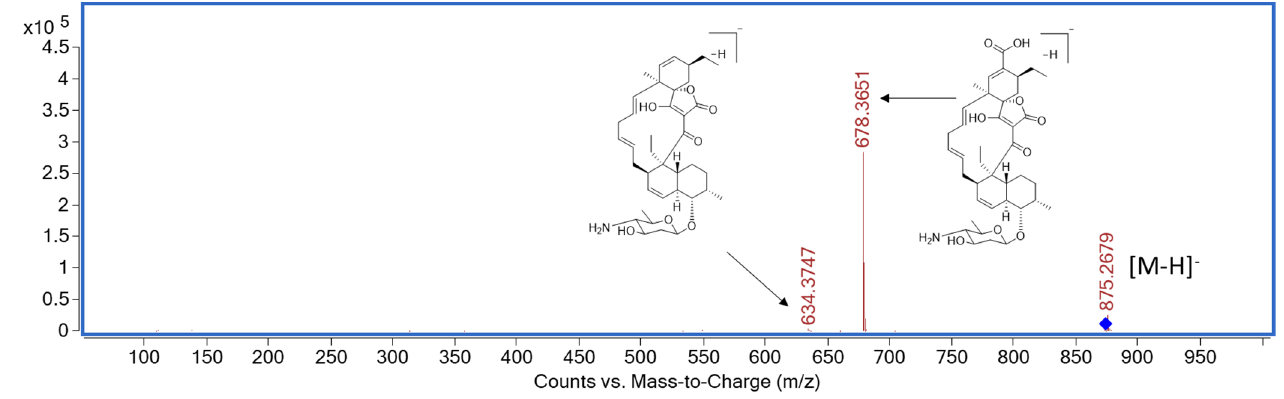
Figure 6. MS/MS spectrum for 7 . Figure 5. MS/MS spectrum for 7 . Figure 4. Selected HMBC and COSY correlations for 7 and 8 .